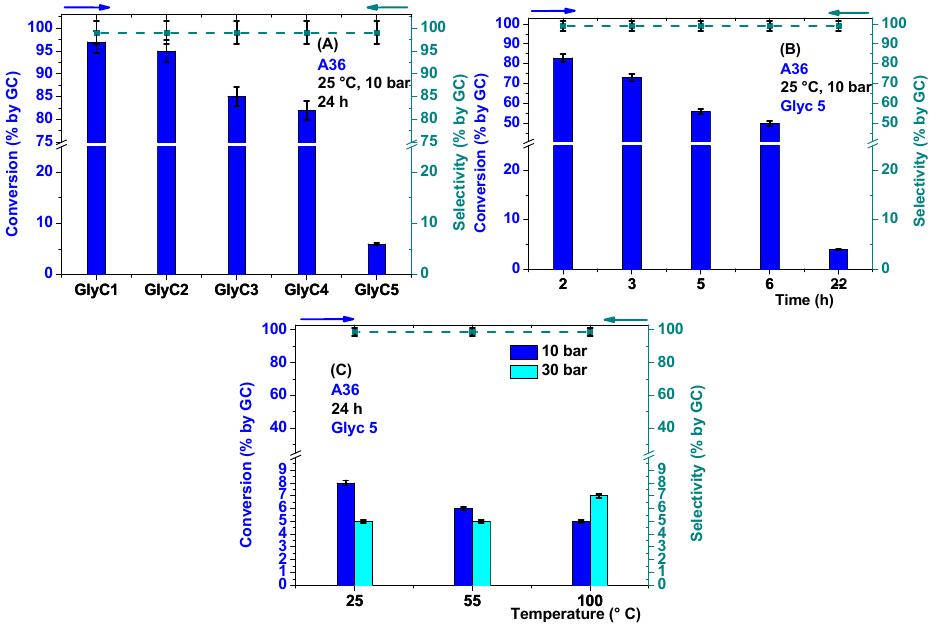
Figure 1. CF-reaction of glycerol with acetone over Amberlyst 36. ( A ) Conversion of glycerol achieved after 24 h, at 25 °C and 10 bar, by feeding different types of reactant Glyc1-5 to the reactor; ( B ) Profile of the glycerol conversion vs. time obtained at 25 °C and 10 bar with the use of Glyc5 as the reagent; ( C ) Effect of T and p on the conversion of Glyc5 achieved after 24 h. In all cases, WHSV = 2 was used. The molar ratio acetone:glycerol was 40 and 4 for Glyc1 and Glyc2-5 , respectively.